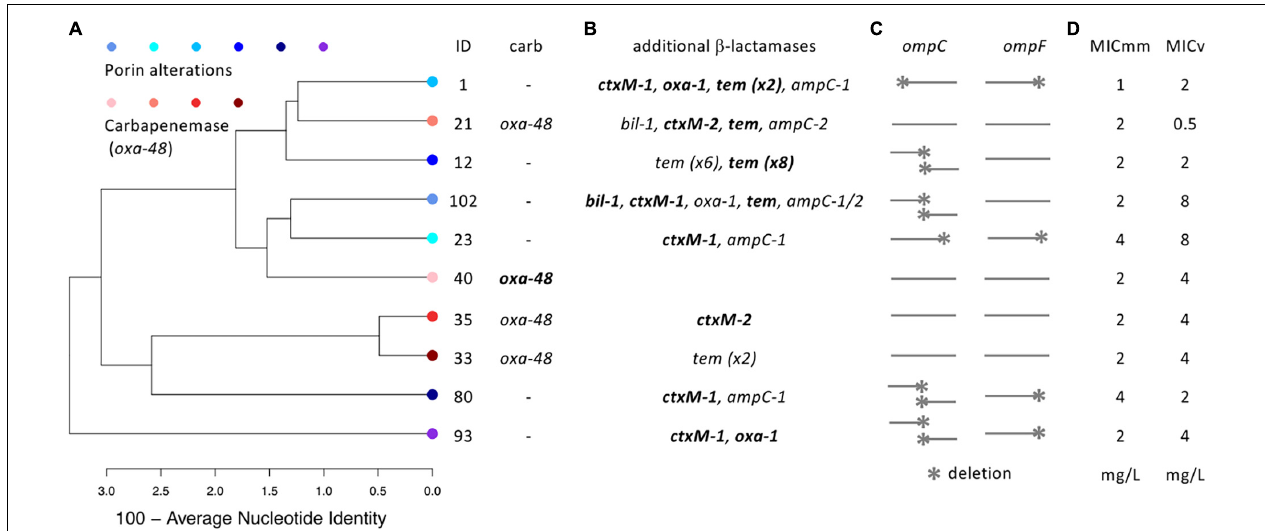
FIGURE 1 | A dendrogram based on average nucleotide identities (ANI) of E. coli isolates of the two resistance groups [carbapenemase ( n = 4) vs porin alterations ( n = 6)] are shown in panel (A) (carb: carbapenemase). Detected genes encoding additional β -lactamases are indicated in panel (B) , where plasmid encoded genes are highlighted in bold (genes detected multiple times are indicated). Deletion sites in ompC/F genes are shown in panel (C) . A graphical outline of respective assembles are given in Supplementary Figure 1 . Minimal inhibitory concentrations (MIC) values for ertapenem are given in panel (D) (“MICv” is based on standard VITEK 2 results, whereas “MICmm” was determined using the minimal medium of this